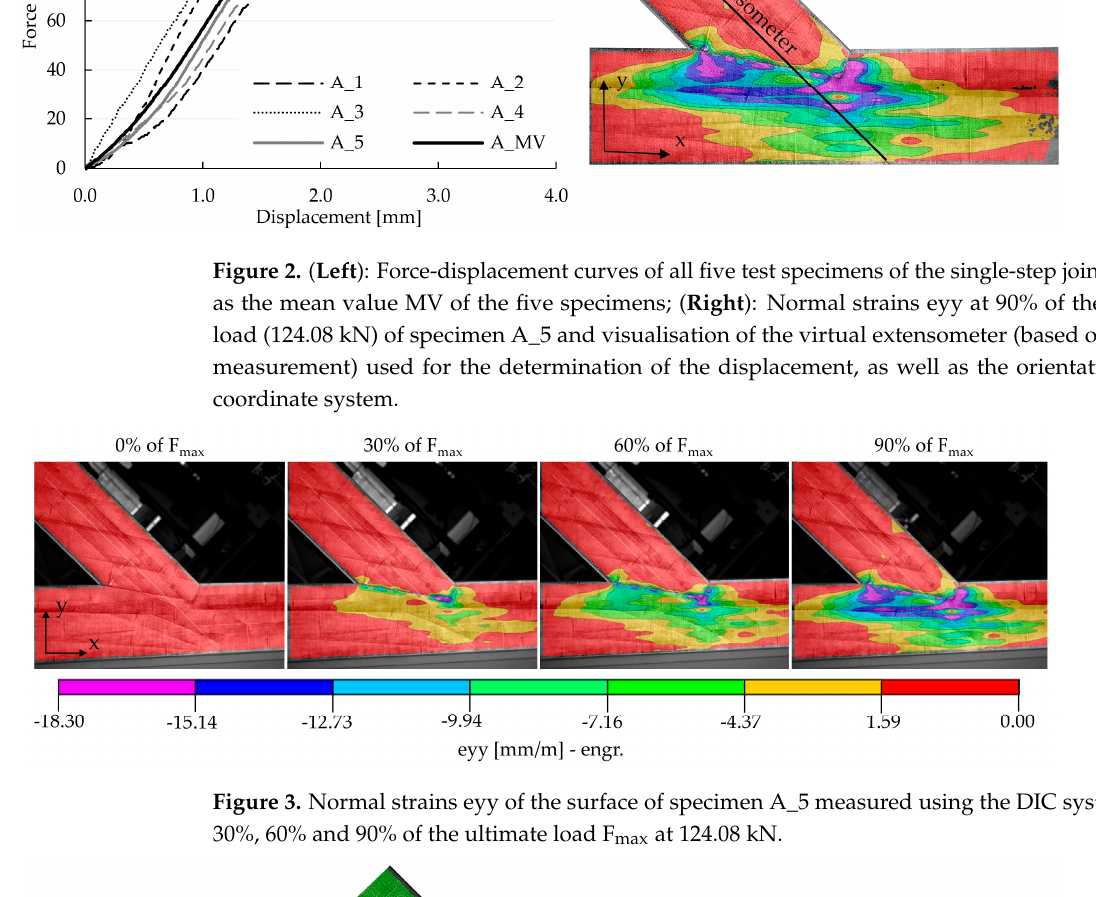
Figure 3. Normal strains eyy of the surface of specimen A_5 measured using the DIC system at 0%, 30%, 60% and 90% of the ultimate load F max at 124.08 kN.